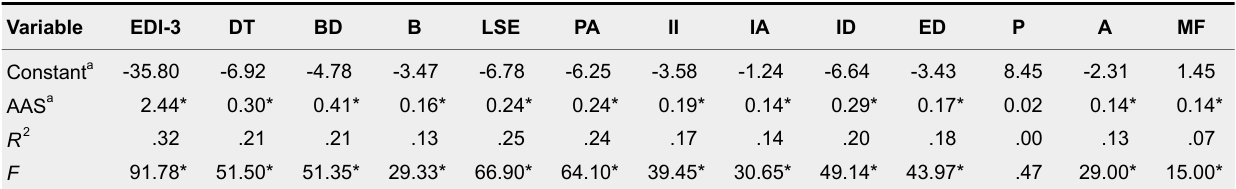
Results of Regression Model Using Total Anxiety About Aging Scale (AAS) Scores to Predict Eating Disorder Inventory-3 (EDI-3) Total and Subscale Scores